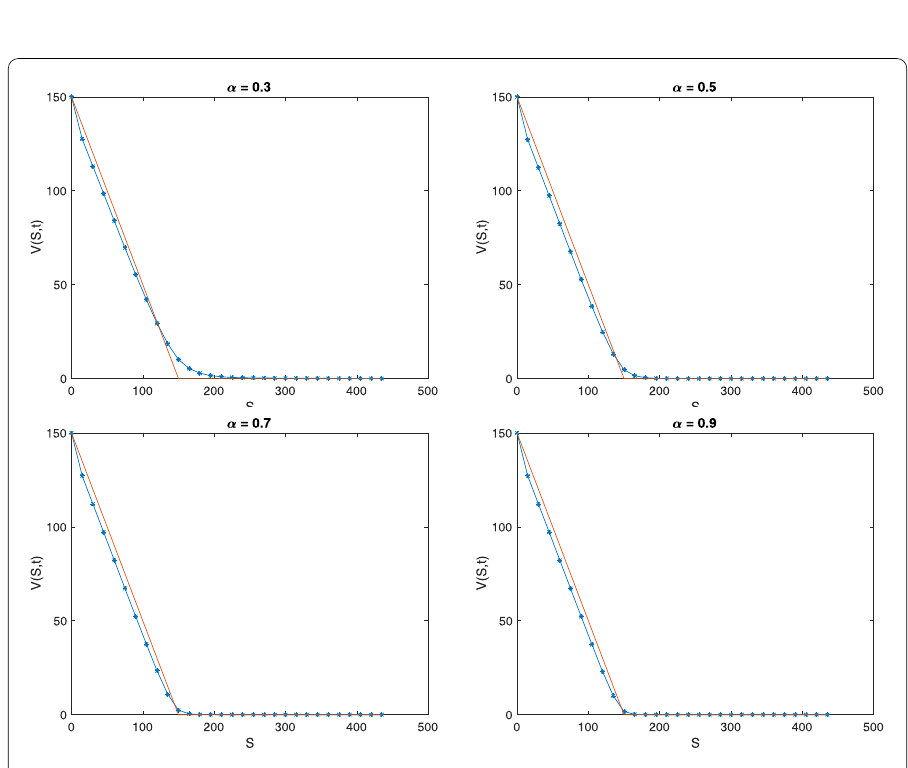
Figure 3 Payoffs under Example 5.1 for α = 0.3,0.5,0.7,0.9; δ = 0.065 at t =